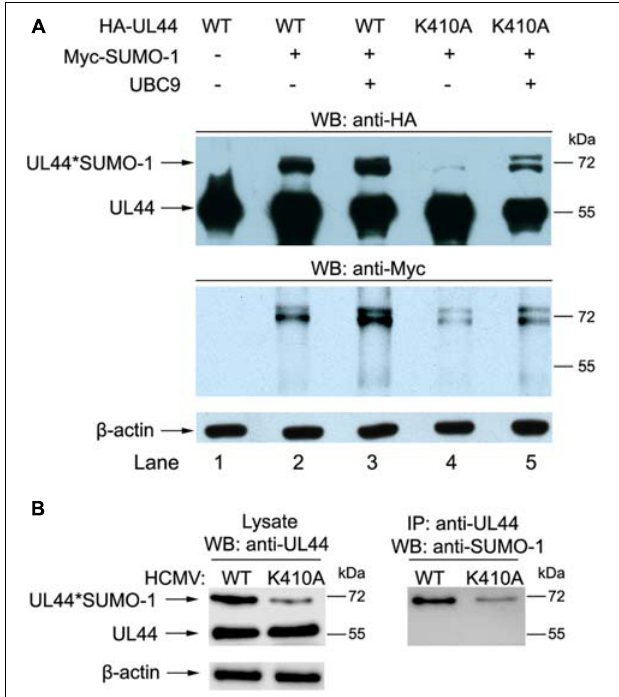
FIGURE 4 | 410 lysine was the major sumoylation site of UL44 in both transfected and infected cells. (A) 293T cells were transiently cotransfected with HA-UL44 (wild-type or K410A mutant), Myc-SUMO-1 and UBC9 as indicated. Forty eight hours later, cells were resuspended and boiled in SDS sample buffer, the supernatants were analyzed by western blot using anti-HA and anti-Myc antibodies. (B) HFF cells were infected with wild-type HCMV (WT) or HCMV containing UL44 K410A mutant (K410A) at an MOI of 1. At 48 h post-transfection, total cell lysates were either directly analyzed by SDS-PAGE, or immunoprecipitated with covalently conjugated anti-UL44 beads, then probed for UL44 or sumoylated proteins using anti-UL44 or anti-SUMO1 antibodies, respectively. For all panels, representative of three independent